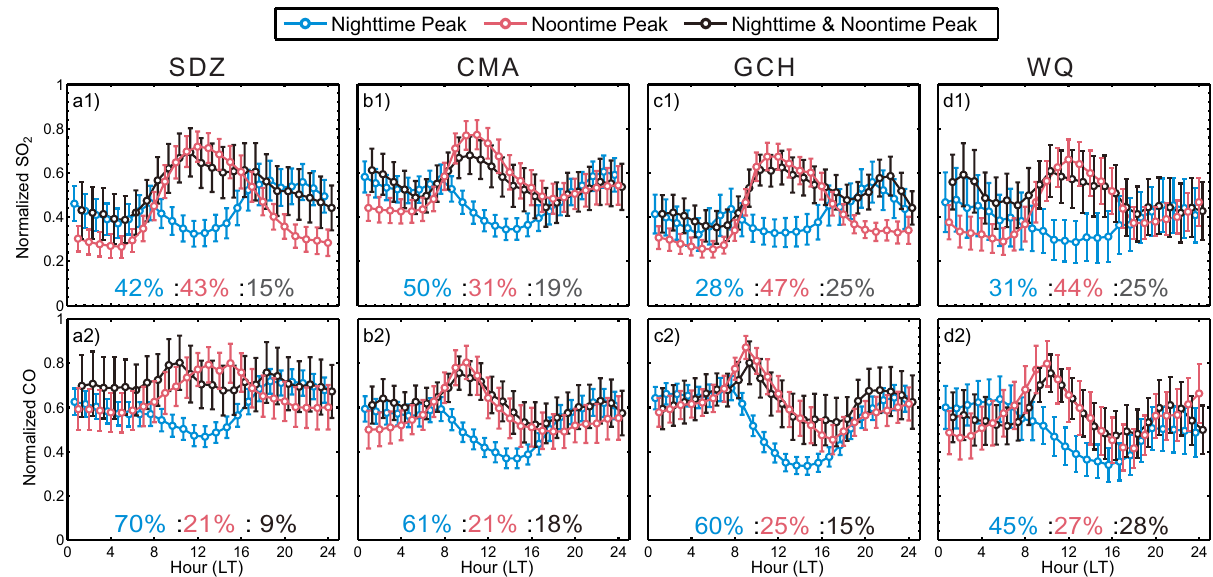
Figure 3. Normalized (1) SO 2 and (2) CO diurnal variation pattern for the days with peaks occurring during nighttime (blue, before 09:00 or after 16:00LT), noontime (red, between 09:00 and 16:00 LT) and during both nighttime and noontime (black) at (a) Shangdianzi, (b) China Meteorological Administration, (c) Gucheng and (d) Wuqing station. The circle and error bar represent the average value ± 3 standard error of the mean.